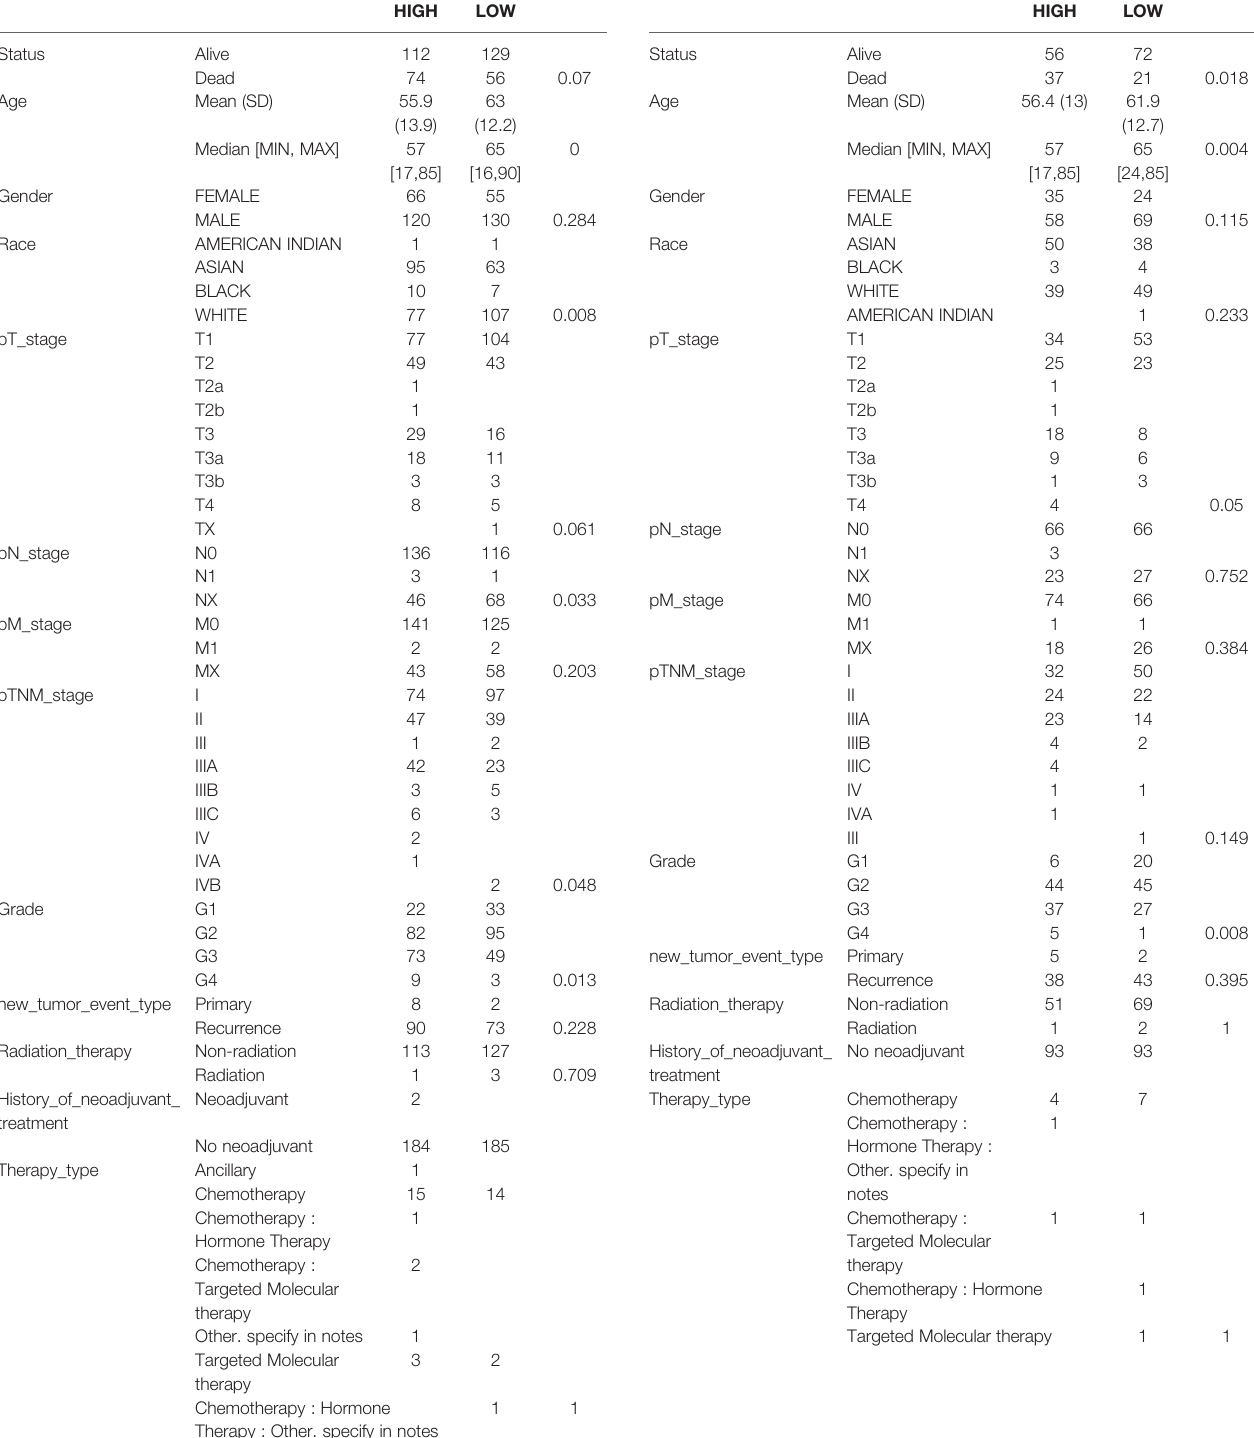
TABLE 4 | Comparisons of clinical characteristics between high and low GFRA3 expression groups. GFRA3-HIGH vs GFRA3-LOW